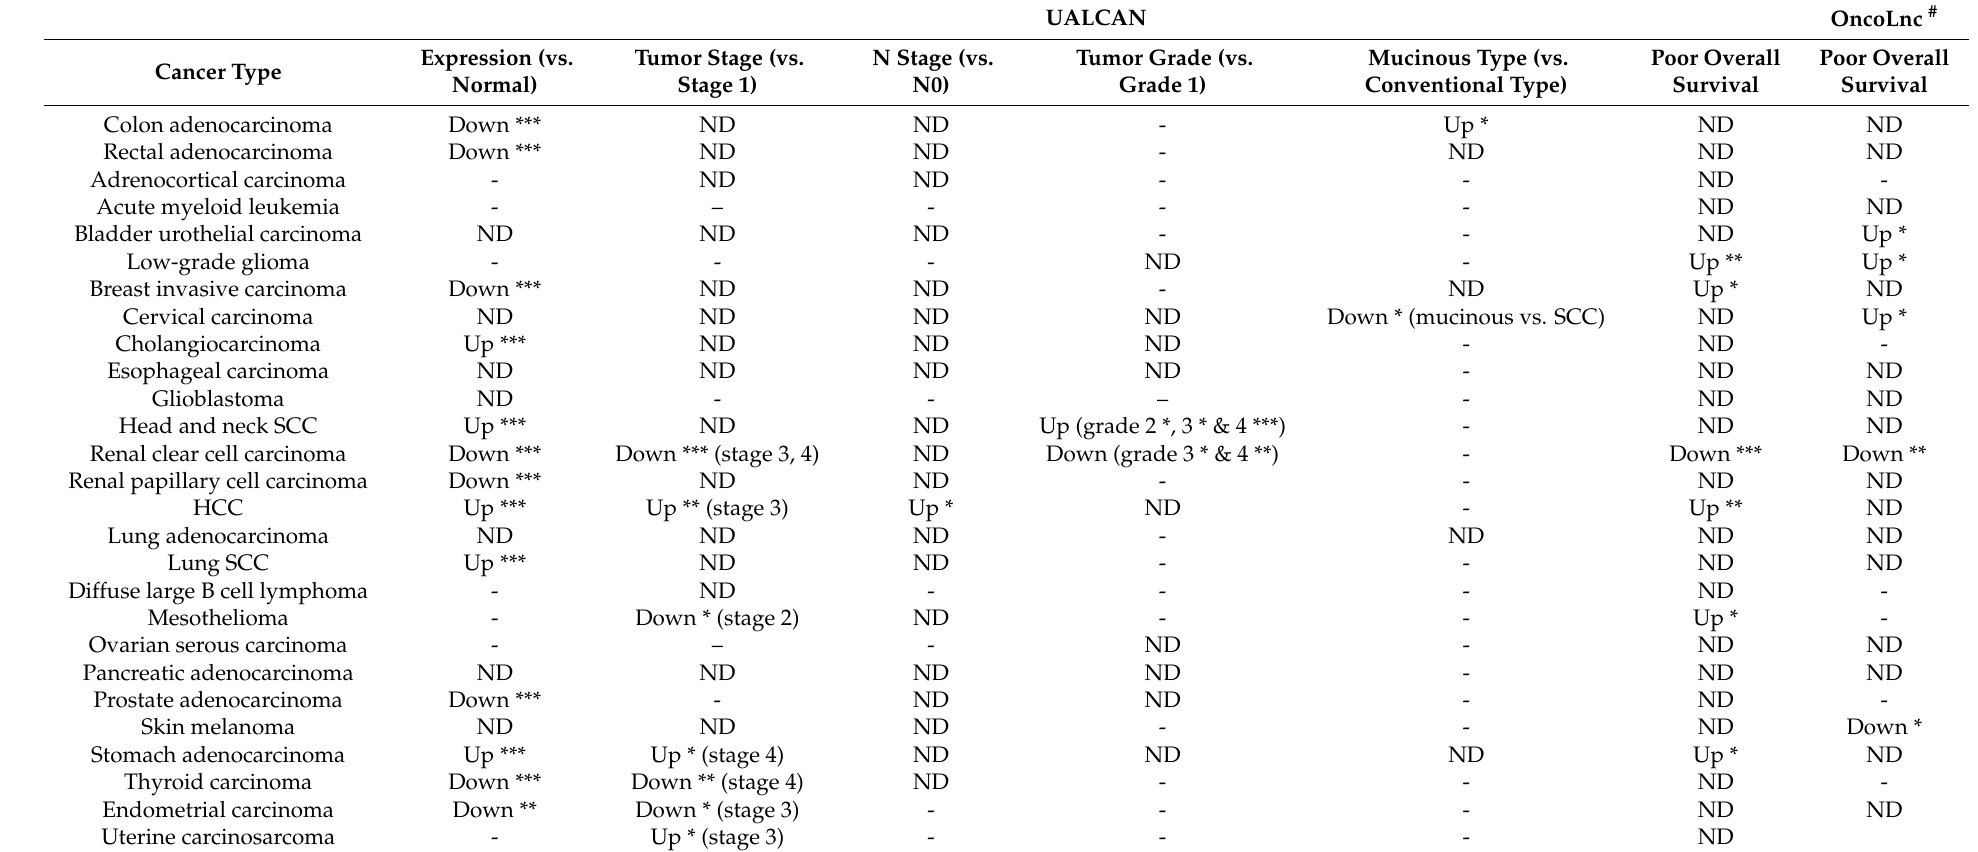
Table 2. Expression pattern of PIK3C3 in human cancer according to the TCGA